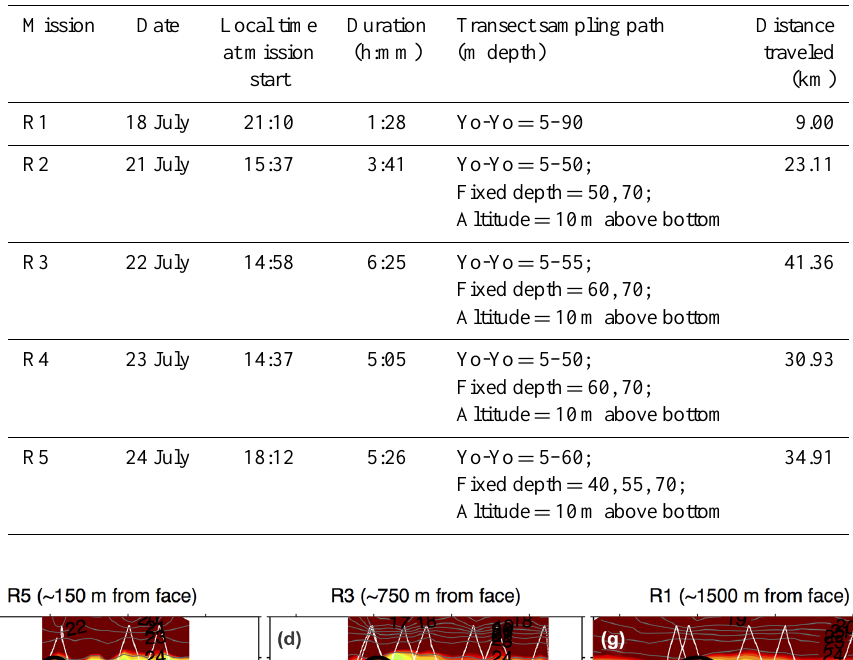
Table 1. REMUS Missions in Sarqardleq Fjord.